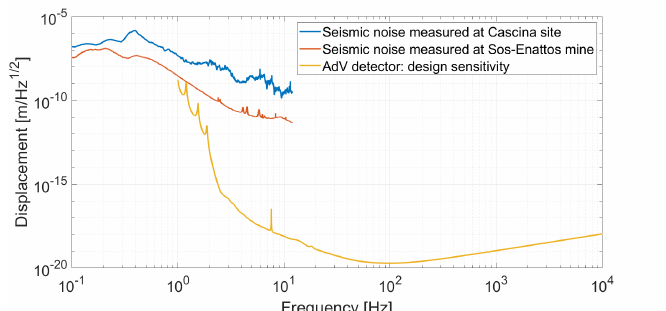
Figure 5. Ground displacement measured at the Cascina site (blue curve) and at the Sos-Enattos mine (red curve) compared to the design sensitivity of the Advanced Virgo detector (AdV). At 10 Hz, the ground displacement is about eight orders of magnitude higher than the sensitivity of the GW